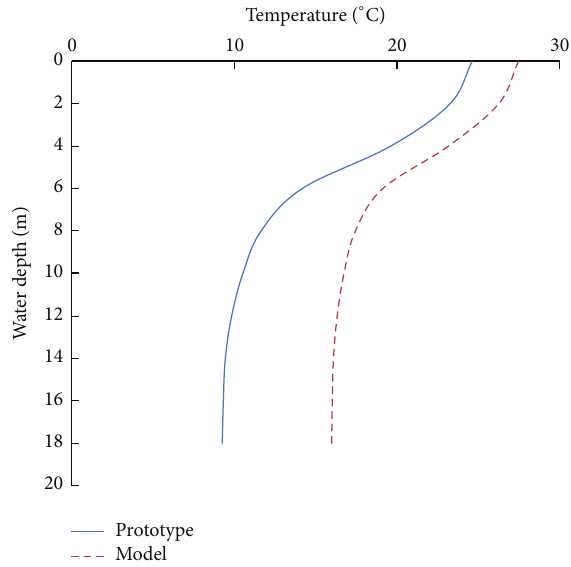
Figure 4: Temperature distribution of the model and the